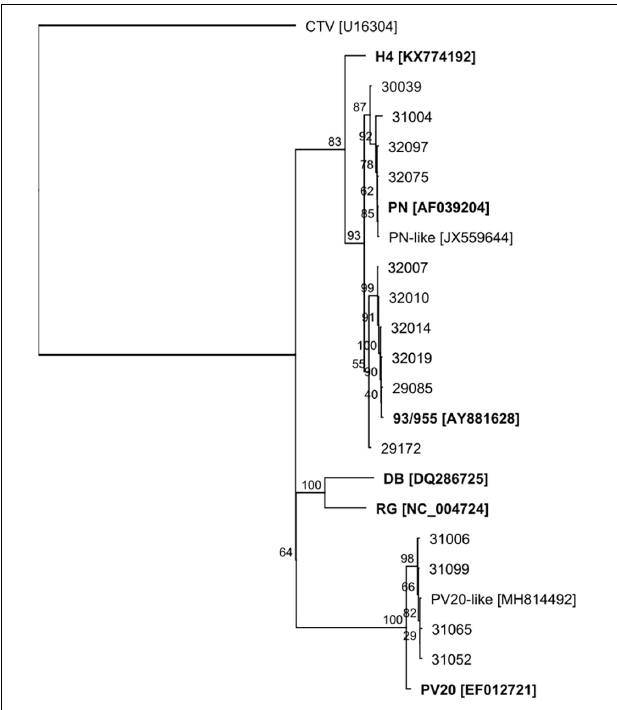
FIGURE 3 | ML phylogenetic tree of the 3 (cid:48) end (2.7 Kb) of the genomes of GLRaV-2 isolates. Reference genomic sequences for the type variants of the virus are included and highlighted in bold. The closterovirus Citrus tristeza virus (CTV) was included as outgroup. The sequences were aligned using MAFFT, and the phylogenetic tree was generated with the PHYML plugin (HKY85 substitution model, 100 bootstraps) available in Geneious. Branches represent bootstrap support